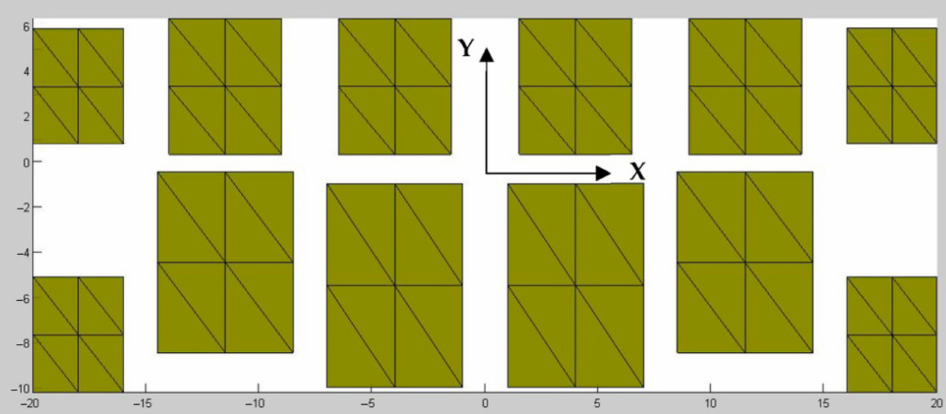
Figure 6. Boundary elements mesh with 96 triangular elements (constant strain approximation) used to analyze the